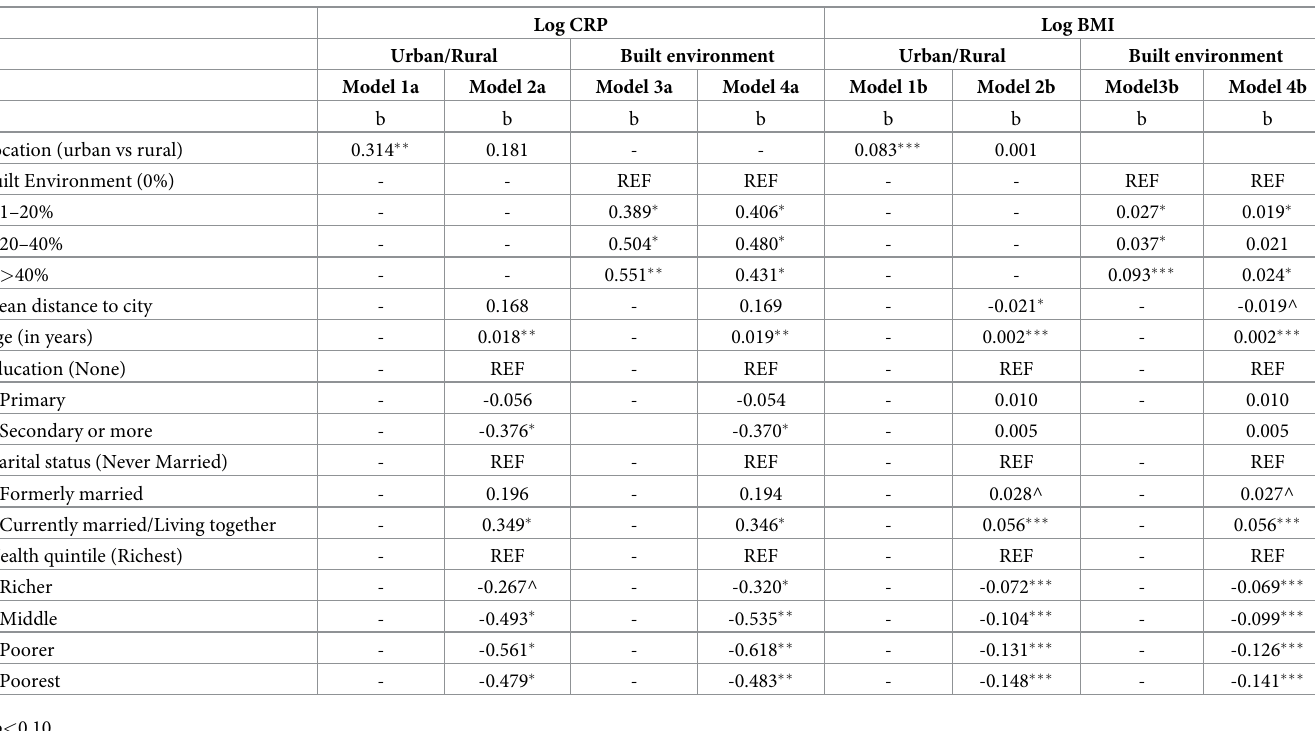
Table 3. Unstandardized beta coefficients from linear regression models of the association between measures of urbanicity and log CRP and log